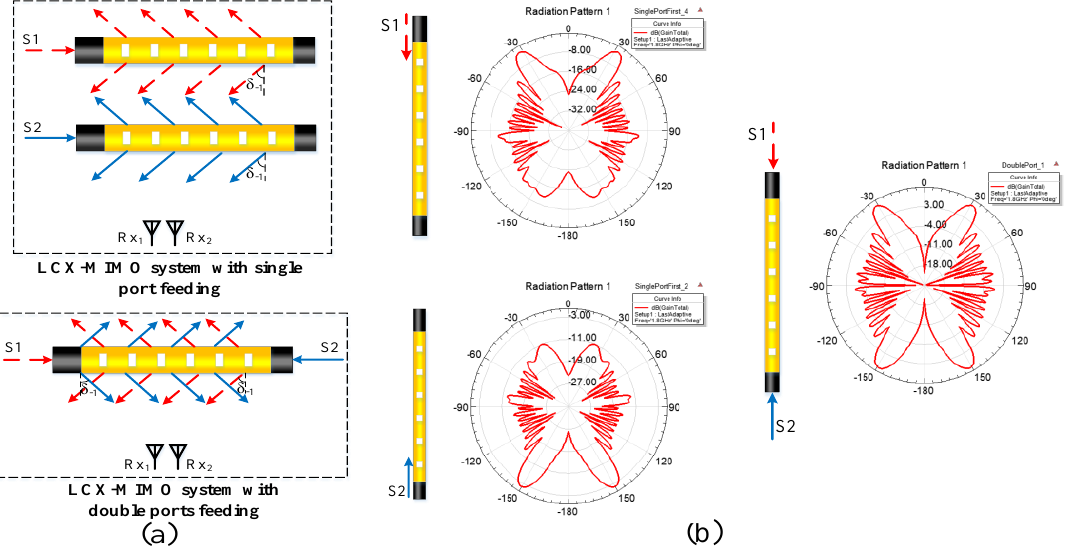
Figure 2. ( a ) Radiation modes of the electromagnetic wave signal for the LCX − MIMO system; ( b ) simulation radiation patterns of LCX by HFSS software (center frequency is 1.8 GHz, period of LCX slot is 0.25 m) .